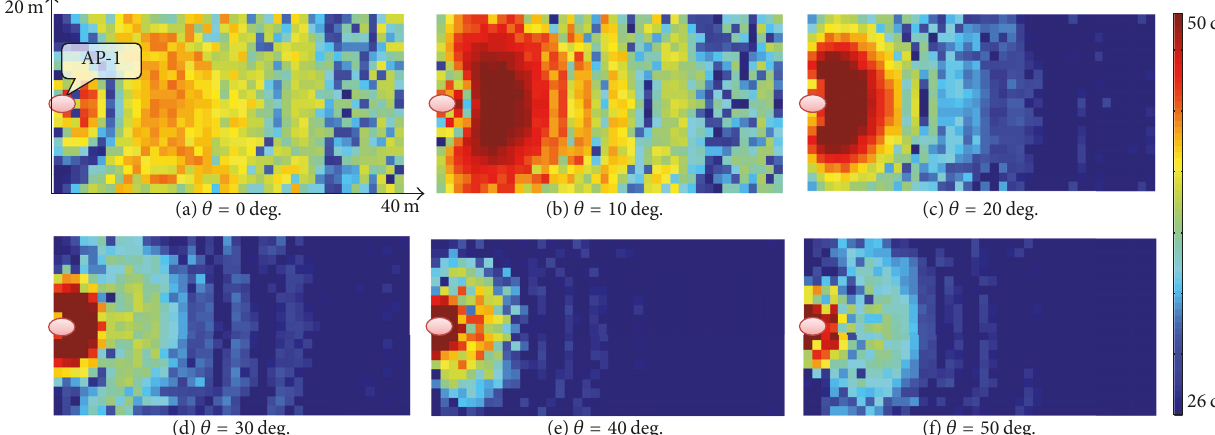
Figure 8: SNR distribution when 𝜃 of AP-1 is set from 0 to 50 degrees.